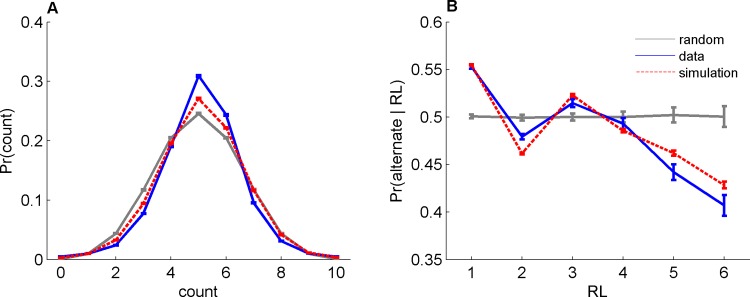
Deviations from randomness (gray) in behavior (blue) and logistic model (red).A. The distribution of Heads’ counts in ten consecutive trials. B. The probability to alternate after a RL trials devoid of alternations (strike). Error bars are SEM.